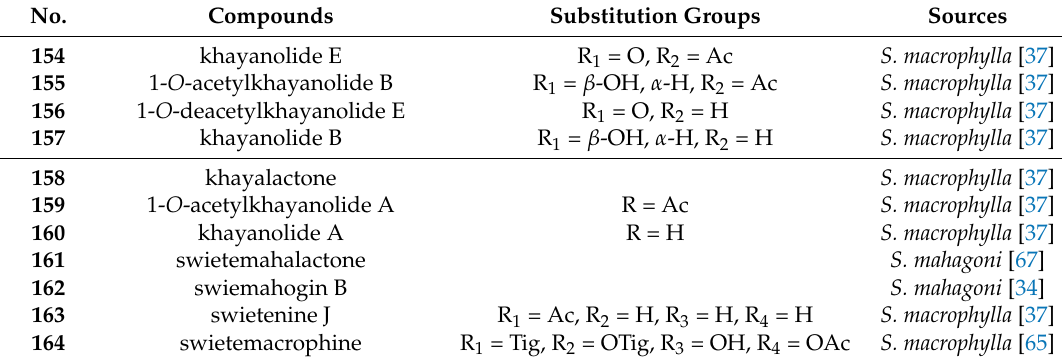
Table 5. Structures and sources of polyoxyphragmalin-type limonoids 154 – 164 .